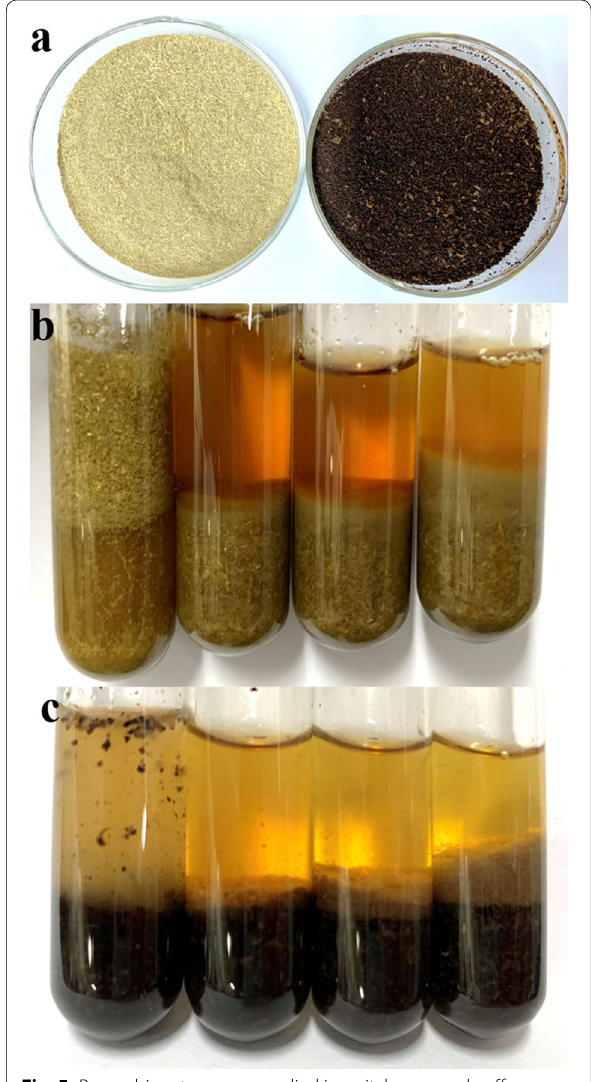
Fig. 5 Recombinant enzyme applied in switchgrass and coffee grounds. a Switchgrass (left) and coffee grounds (right) raw materials following oven-drying. b Hydrolyzation of switchgrass by crude enzyme, with (left to right) the control, 10%, 20%, and 40%. c Hydrolyzation of coffee grounds by crude enzyme, with (left to right) the control, 10%, 20%, and